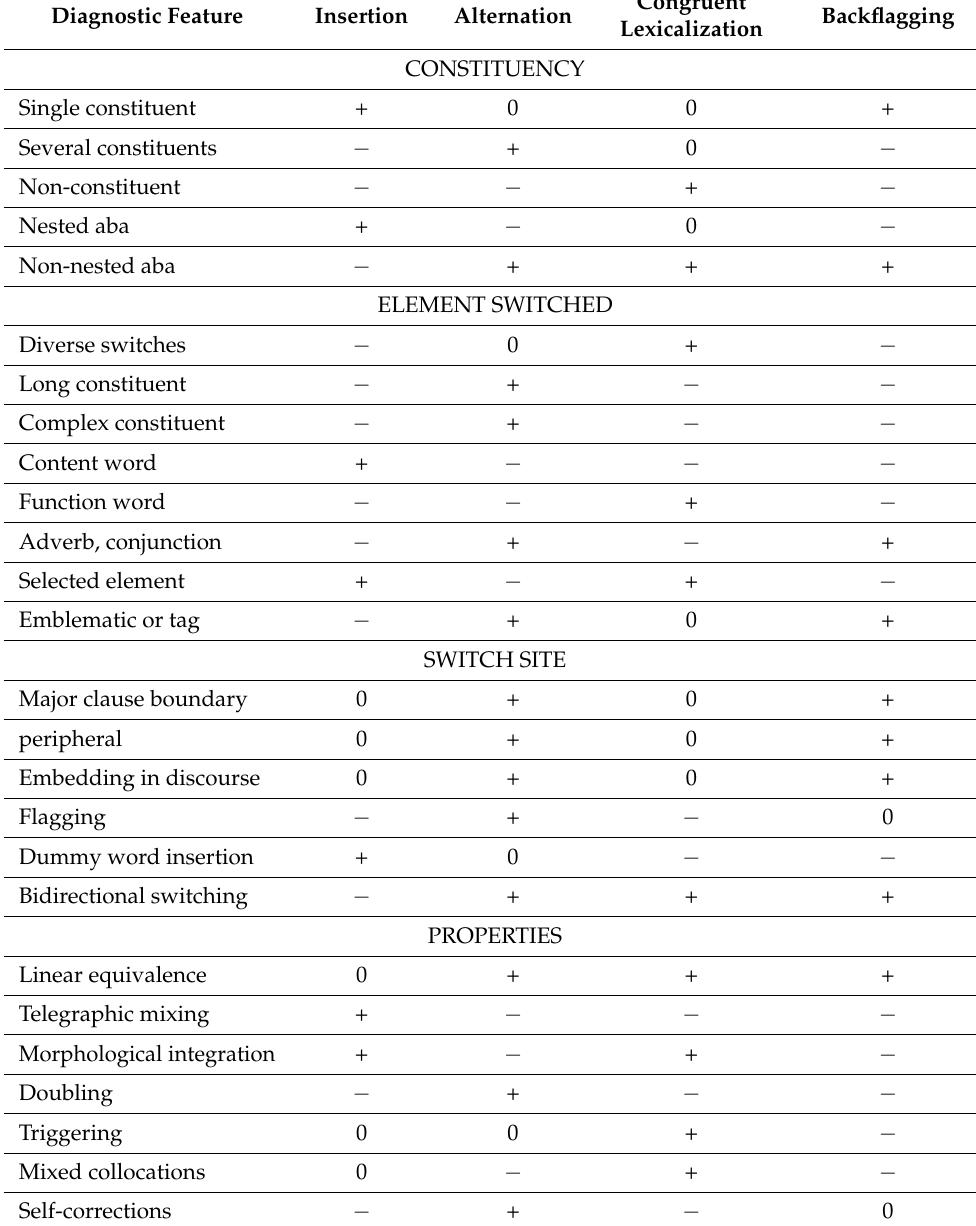
Table 1. Diagnostic features of the three patterns of code-mixing (Muysken 2000, p. 230), augmented with the category of backflagging (Muysken